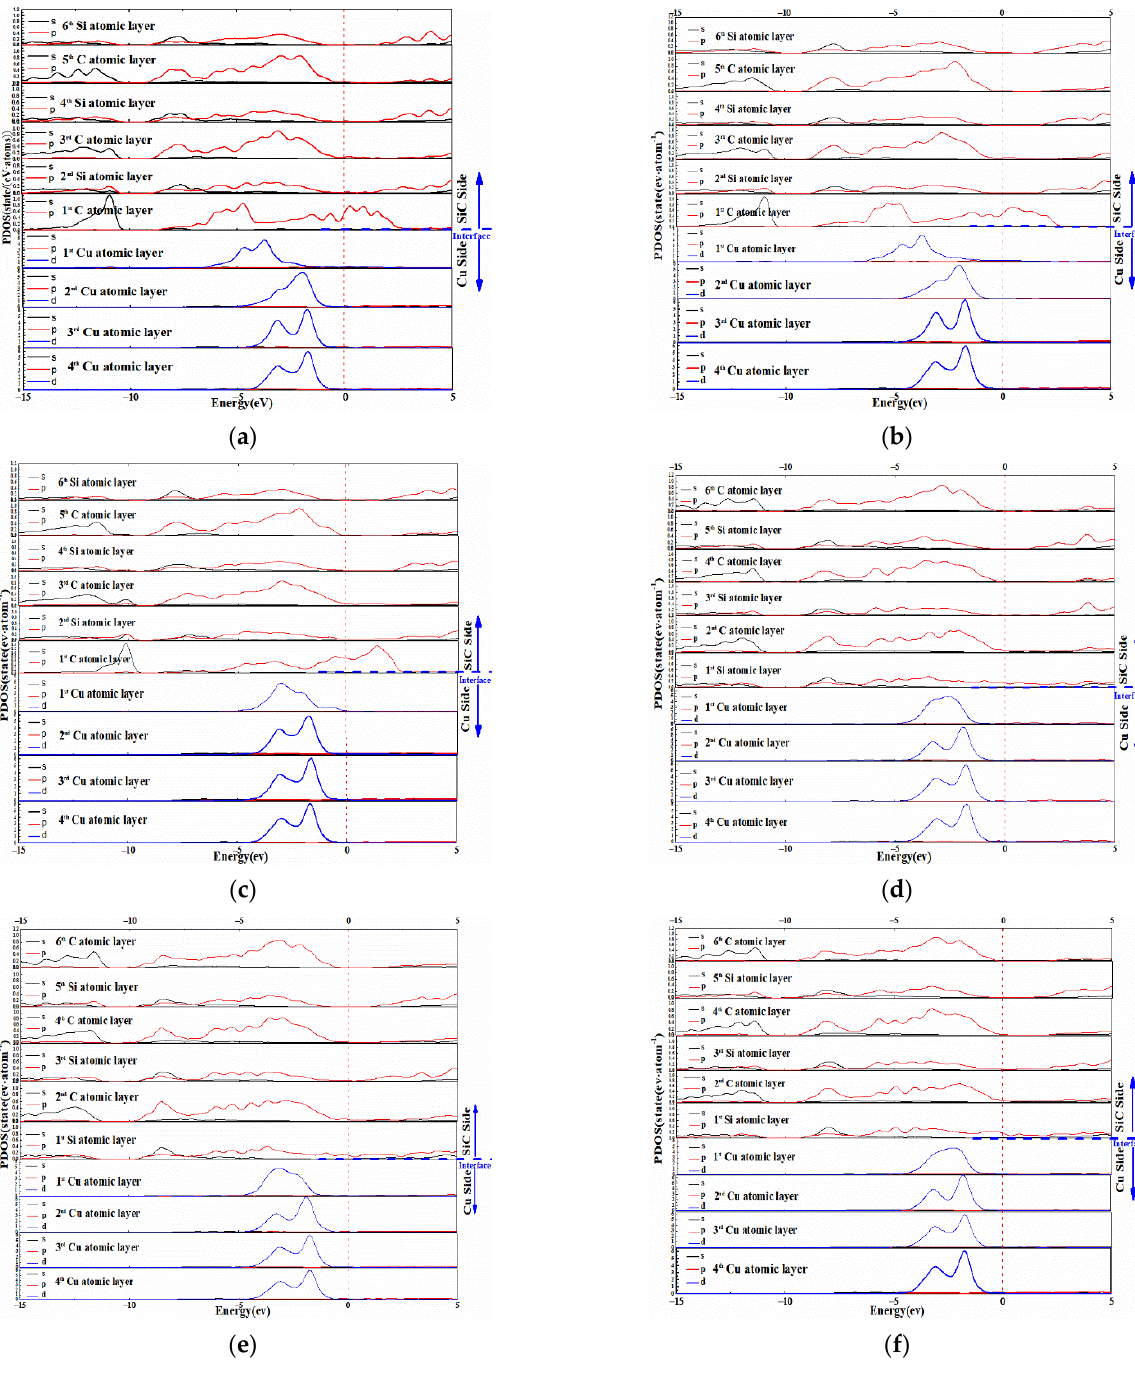
Figure 8. Partial density of state of the interfacial atoms of all “(a)” types of 6H-SiC(0001)/Cu(111) interfacial models. ( a ) CT-HCP(a); ( b ) CT-MT(a); ( c ) CT-OT(a); ( d ) ST-HCP(a); ( e ) ST-MT(a); ( f ) ST-OT(a). The curves of the PDOS of the ST-6H-SiC(0001)/Cu(111) are different from those